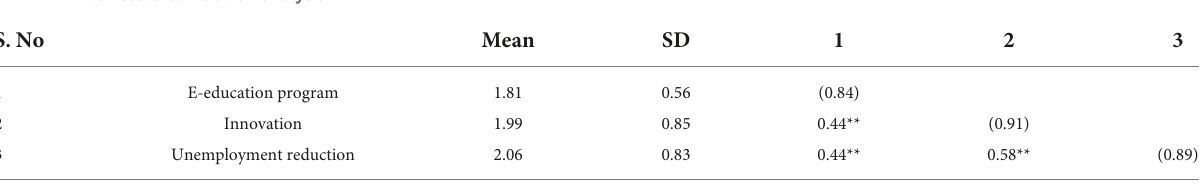
TABLE 2 Inter-scale correlation analysis.